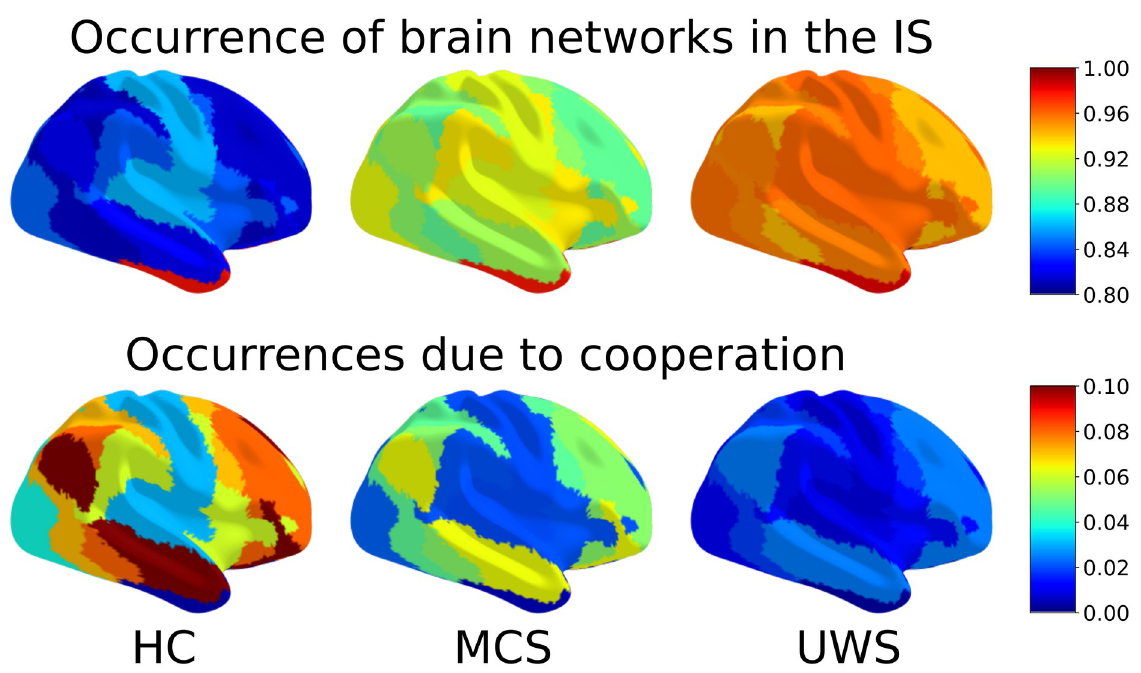
Fig 7. Presence of brain networks in the IS and cooperative interactions. The proportion in which each network appears in the global stable point of the IS (which is equal to appearing in any point of the IS) is shown above. Values range from 0.8 to 1. The highest values appear in UWS patients, followed by MCS. This is due to higher values of NoEL and frondosity. However, this does not imply complex behaviour in brain dynamics. The proportion of occurrences of each network in the IS due to cooperative interactions of other networks is shown below. The values are between 0 and 0.1. The highest values belong to HC (the leading group in terms of coperative measures, followed by MCS, see Fig 6). A greater differentiation between networks is observed than when looking at the global stable point alone. The highest values in all three groups correspond to DMN followed by